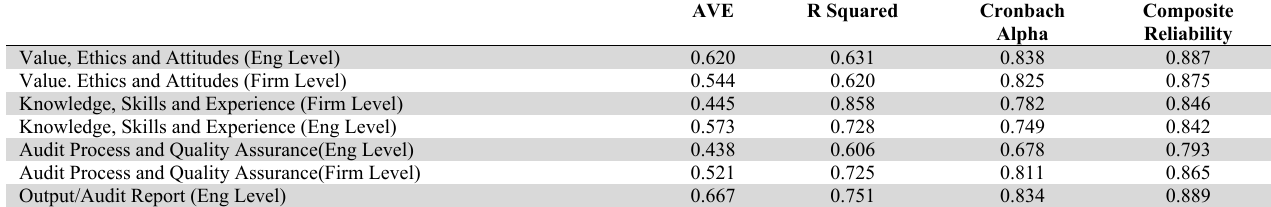
Reliability, Internal Consistency and Average Variance Extracted